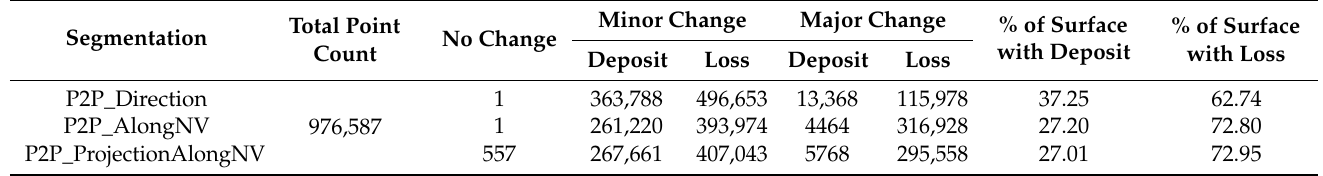
Table 13. Analysis and results for the dataset of ES1.